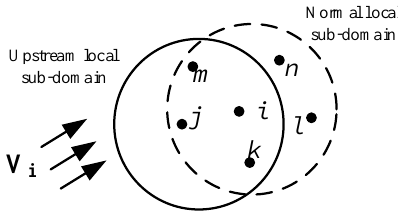
Figure 2. The upstream nodes in the meshless method.